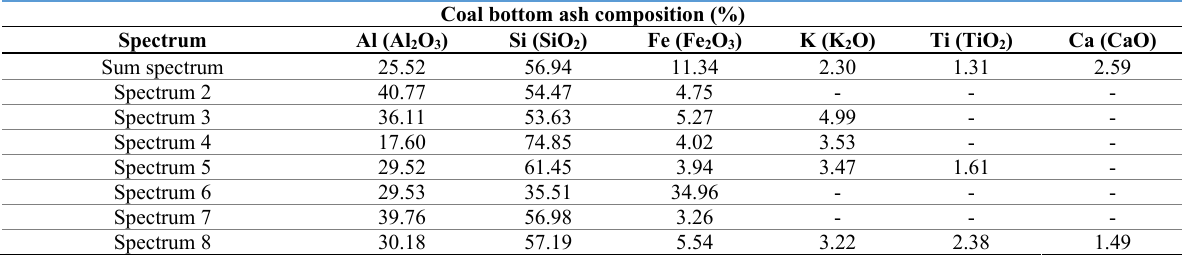
Table 4 – Chemical composition of coal bottom ash obtained by EDS